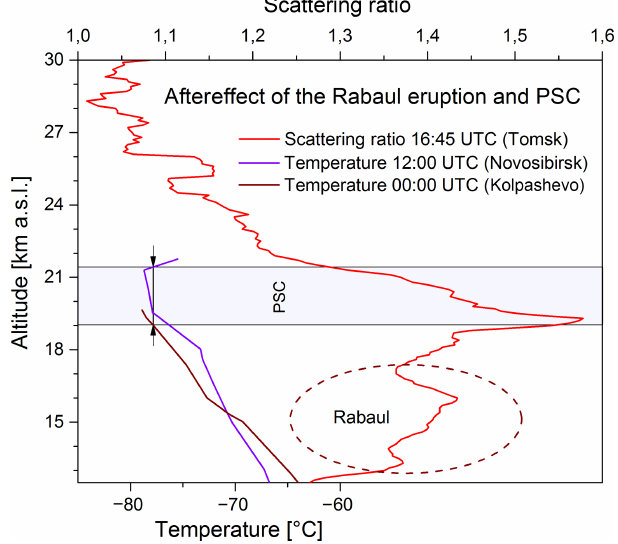
Figure 14. Detection of PSCs formed at extremely low tempera- tures ( < − 78 ◦ C) in the stratosphere over Tomsk. Temperature pro- files were obtained from radiosondes launched on 27 January 2007 in Kolpashevo (station 29231) at 00:00UTC and in Novosibirsk (station 29634) at 12:00UTC (WWW, 2007). The dashed ellipse denotes the aftereffect of the Rabaul volcanic eruption that occurred in Papua New Guinea on 7 October 2006.